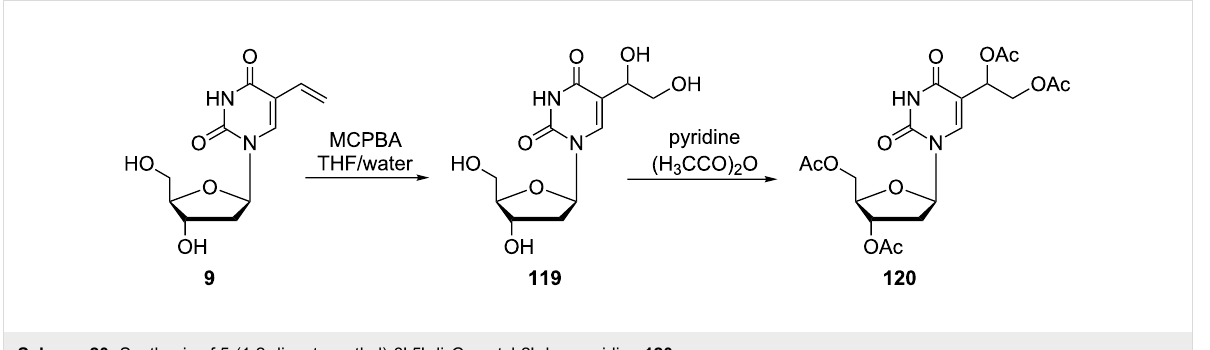
Scheme 20: Synthesis of 5-(1,2-diacetoxyethyl)-3',5'-di- O -acetyl-2'-deoxyuridine 120 .